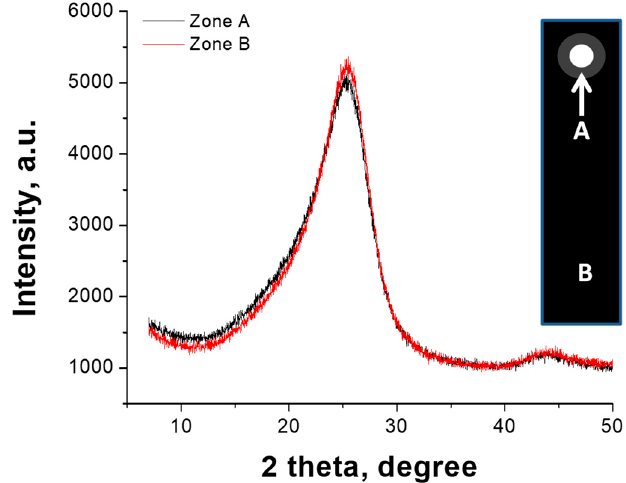
Figure 10. ( a ) Macrograph of FBJ cross-section view. ( b , d ) SEM images of the left side of FBJ cross section ( c , e ). SEM images of the right side of FBJ cross section.